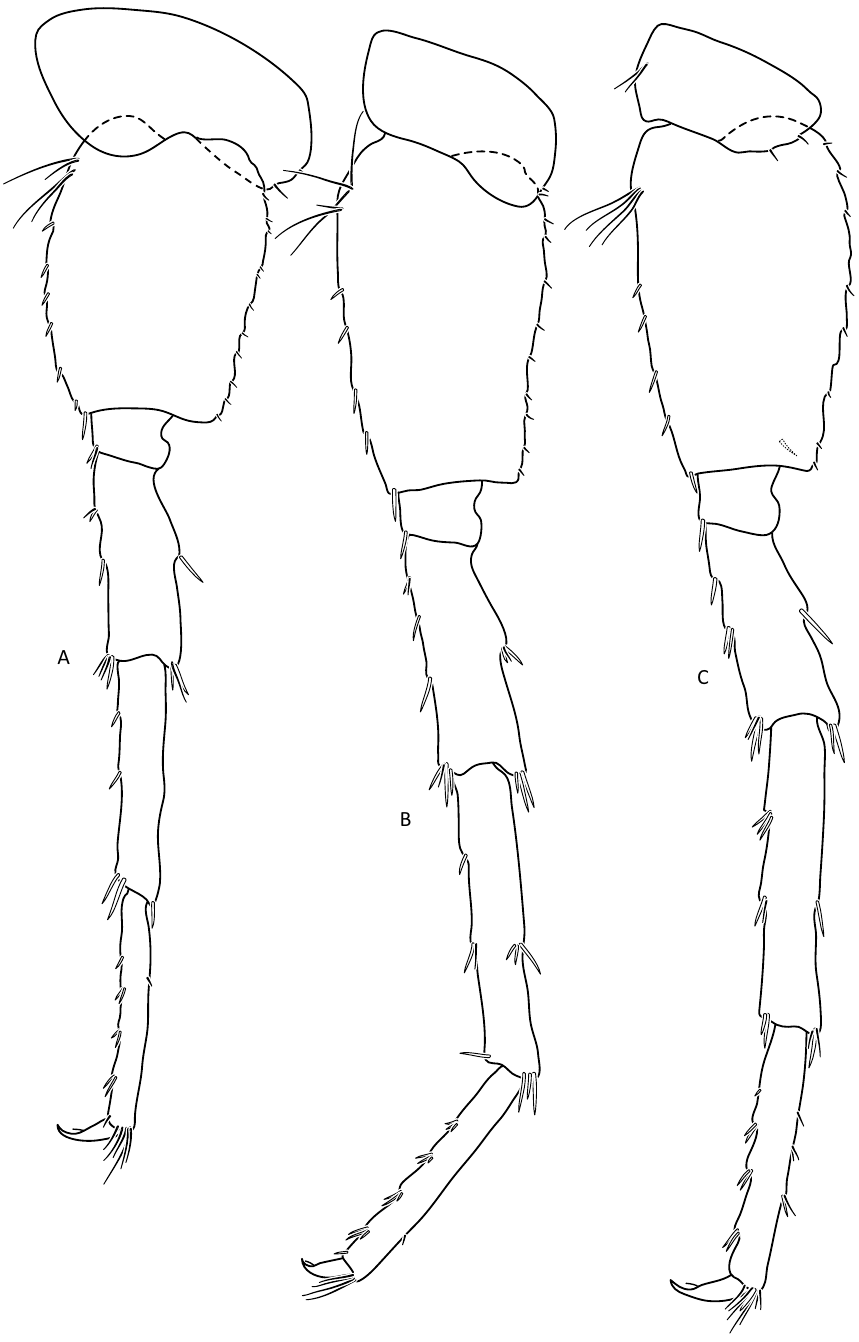
Figure 12. Gammarus tatrensis , male—14 mm. ( a ) pereopod 5, ( b ) pereopod 6, ( c ) pereopod 7. Female (Figs. 13, 14, 15): max. length observed 13 mm. Setae on the lower margin of A 2 peduncle articles 4 and 5 longer than in males; the longest setae of the 4th article are a bit longer than this article width; longest setae of 5th article are up to 1. 5 × times longer than this article width (Fig. 13b). Posterior margin of pereopod 3 merus richly setose—in 3–4 groups altogether 10–15 setae (Fig. 14a); the longest 1. 5 × longer than merus